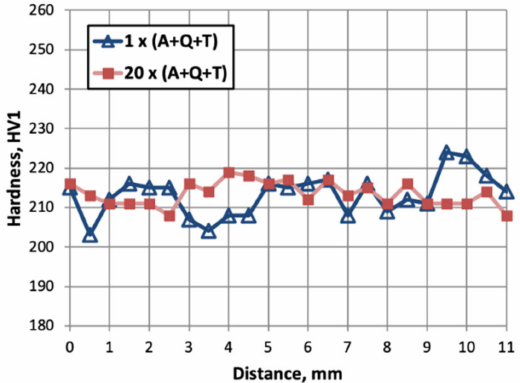
Figure 21. Hardness scan of the 10 mm TIG weld after one full PWHT (A + Q + T) and after twenty repetitions. The measurement was performed through a cross-section of the weld and about 3 mm from the top of the plate surface. The imprint spacing is 0.5 mm. The average hardness is the same in both lines: 213